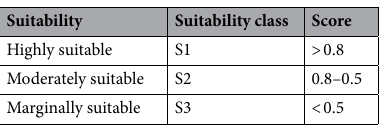
Table 3. LS classes of the study area 58